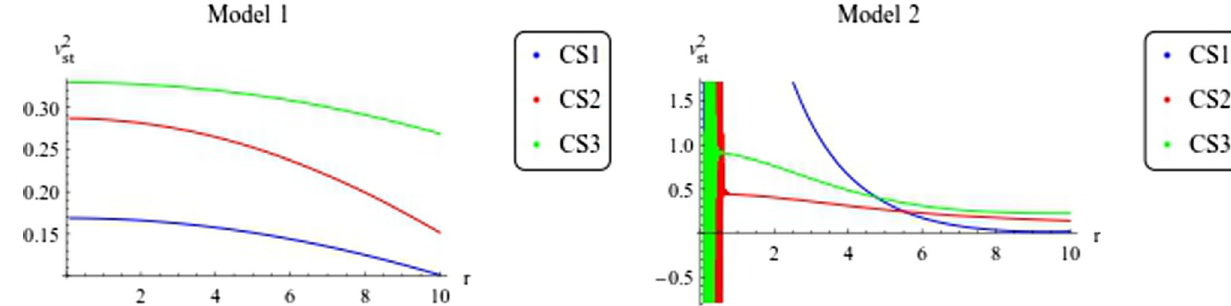
Fig. 11 Change in v 2 st versus r (km) of CS1, CS2 and CS3